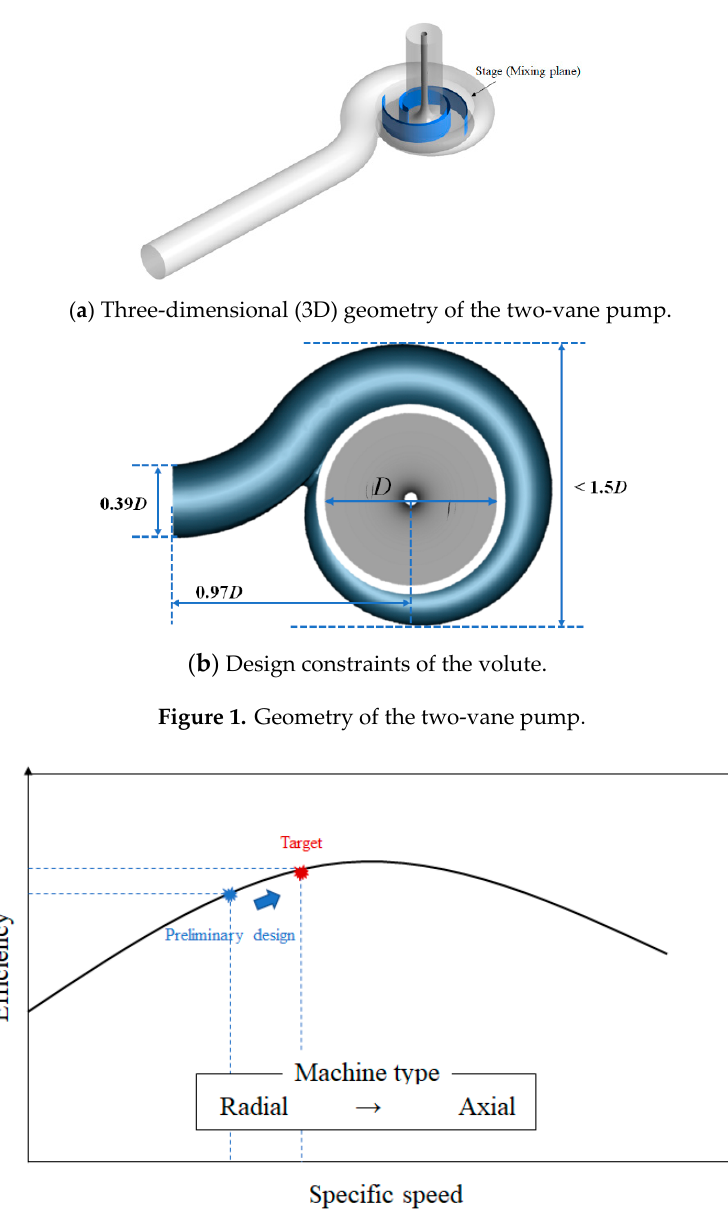
ffi ciency according to the specific speed for the Figure 2. Efficiency according to the specific speed for the pump. Figure 2. E